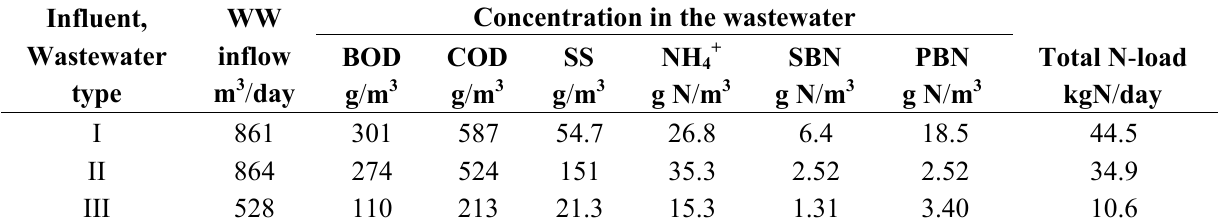
Table 1. Annual average influent